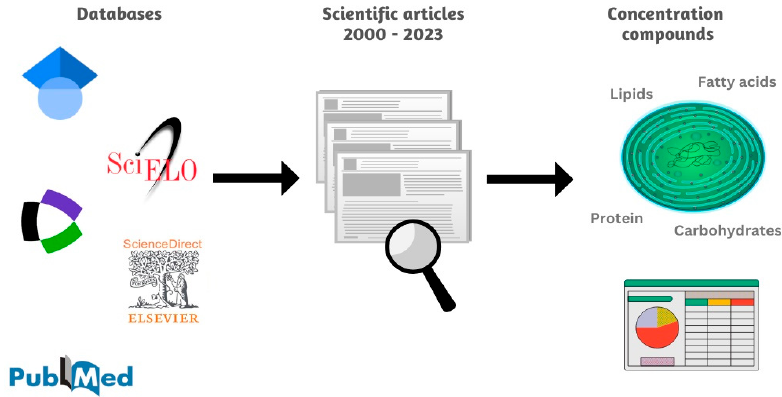
Figure 1. Platforms used in the search for scientific articles for review, date of chosen scientific articles, and primary metabolites revised.